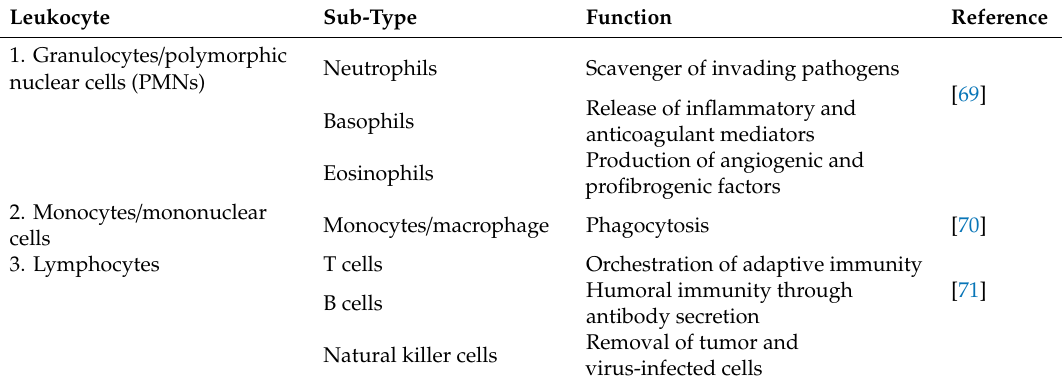
Table 2. Cellular players of innate immunity, their sub-types and